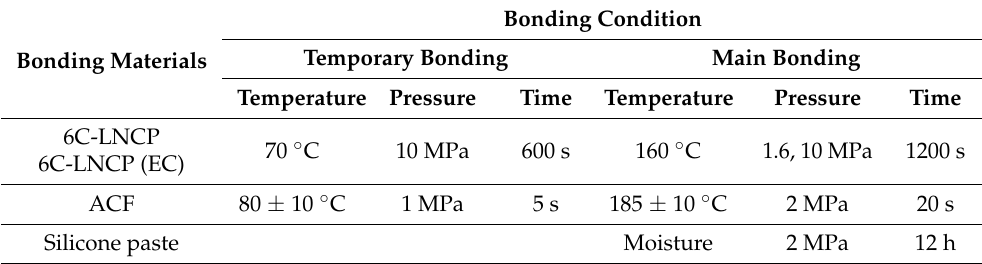
Table 1. Processing conditions for bonding.